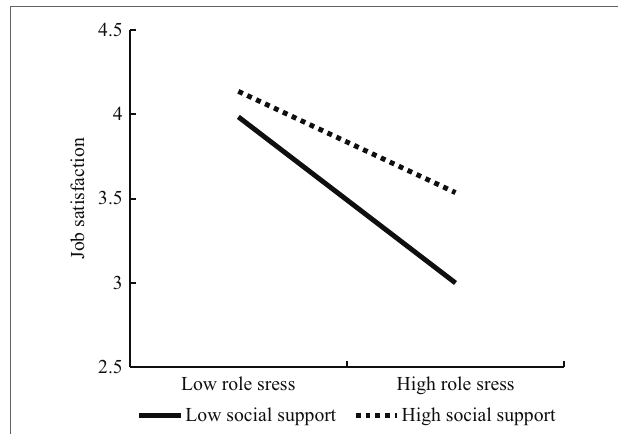
FIGURE 2 | The interaction between role stress and social support on job satisfaction.